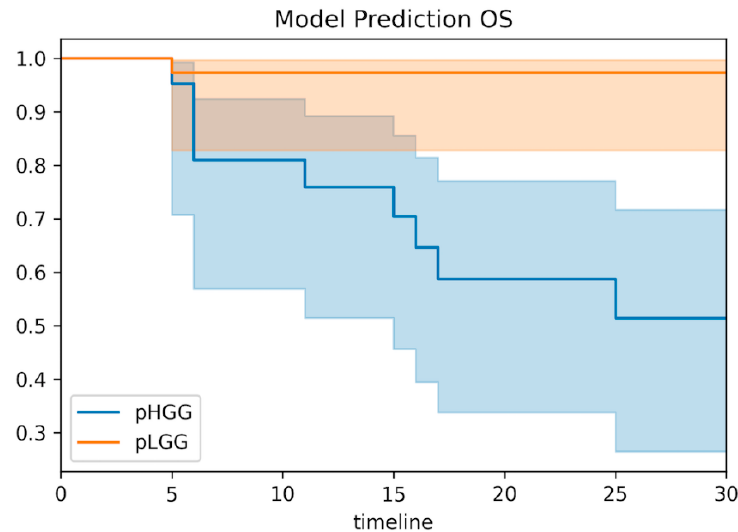
Figure 5. Model correlations with patient overall survival. Based on the combined predictive model, patients were classified as pHGG or pLGG based on the probability threshold of 17.3%. Kaplan–Meier estimates of model predictions presented significant correlations with patient overall survival (OS) ( p < 0.001).